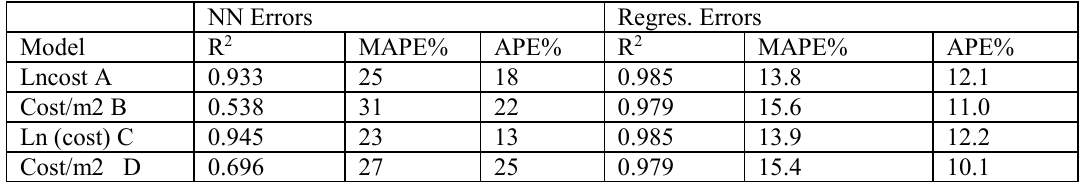
Table (2) Comparison Between NN model & Regression